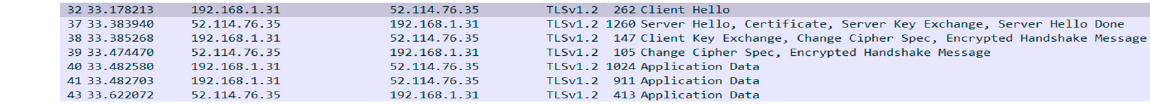
Figure 9. configTime function.